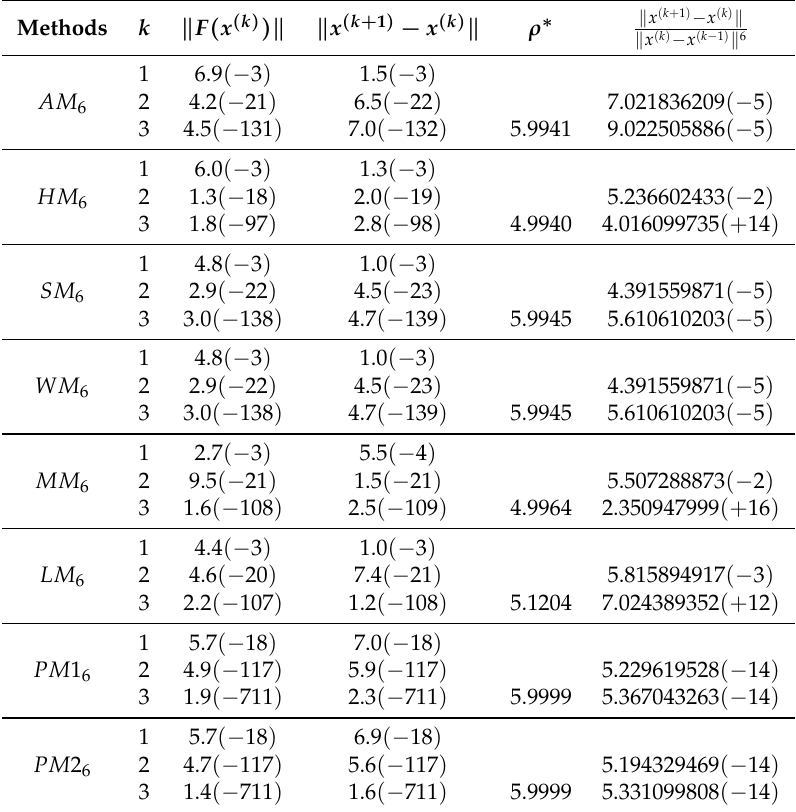
Table 5. Comparisons of different methods on Fisher’s equation in Example